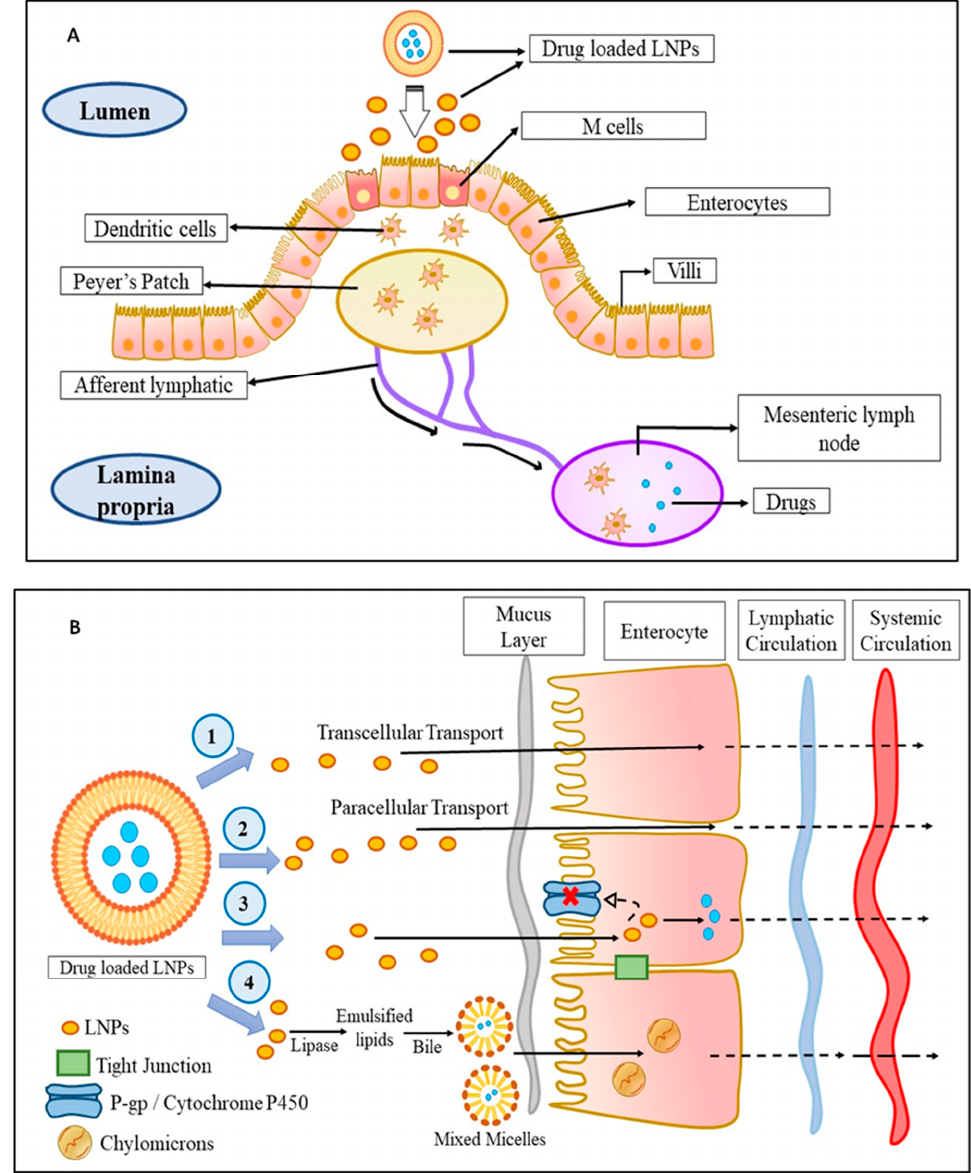
Figure 1. The mechanism of LNPs uptake into the lymphatic circulation: ( A ) Uptake of drug-loaded LNPs by Peyer’s patch into the lymphatic system: The drug-loaded LNPs are taken up by the M-cells of the enterocytes which are then taken up by the dendritic cells followed by Peyer’s patch from where the drug-loaded LNPs enter into the lymphatic system via afferent lymphatic. ( B ) Uptake of drug-loaded LNPs by an intestinal wall into the lymphatic system: The drug-loaded LNPs enter the lymphatic system through the intestinal wall in fours ways—(1) transcellular transport, (2) paracel- lular transport, (3) by inhibiting P-gp glycoprotein and cytochrome P450, or (4) by the production of chylomicrons. Abbreviations: M cell: membranous cell, LNPs: lipid-based nanoparticles; P-gp: